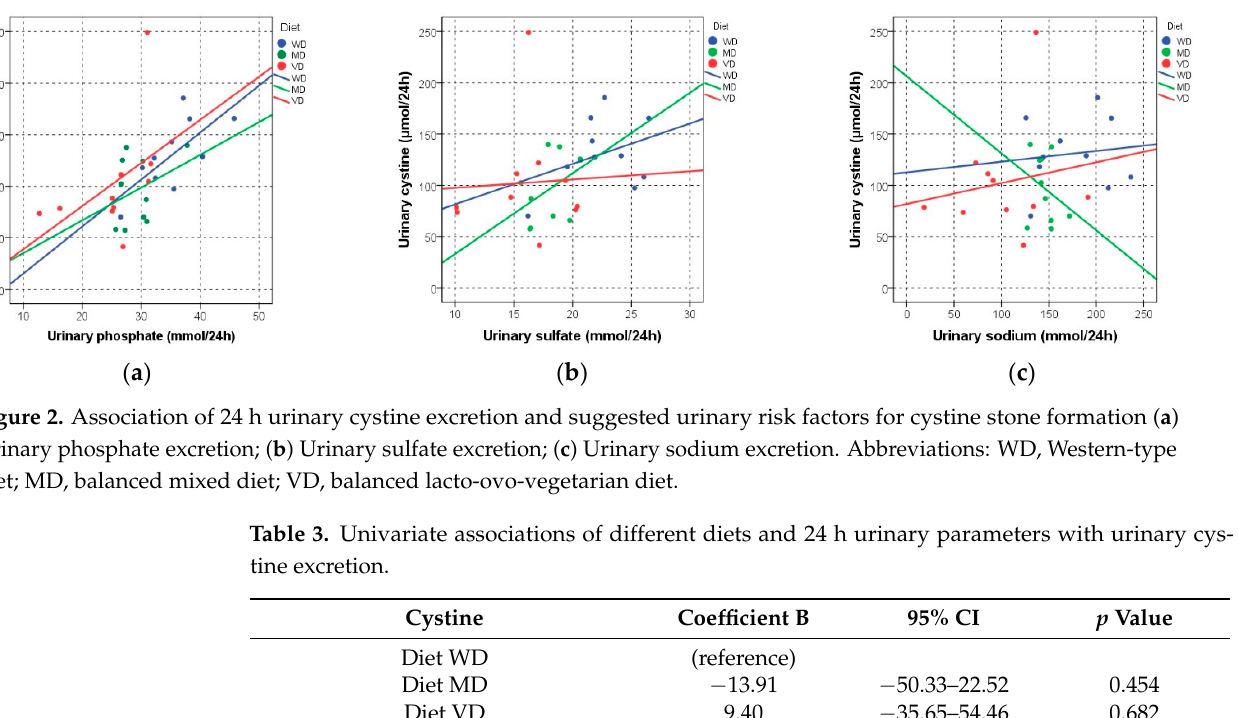
Table 3. Univariate associations of different diets and 24 h urinary parameters with urinary cystine excretion.